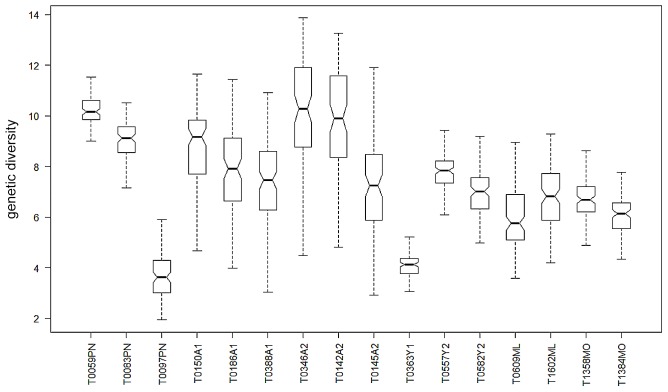
Genetic diversity of infrapopulations.Values of genetic diversity as calculated by the neutral mutation rate (θ) [26] for each individuals' infrapopulation across the study area (presented from west to east). A notched box plot represents θ values and their distributions with median value shown as darkened horizontal line. The width of the notches is proportional to the interquartile range of the sample and inversely proportional to the square root of the size of the sample. Whiskers represent 1st and 3rd quartiles of the distribution. The corresponding numbers of strains for each infrapopulation are found in Table 1.